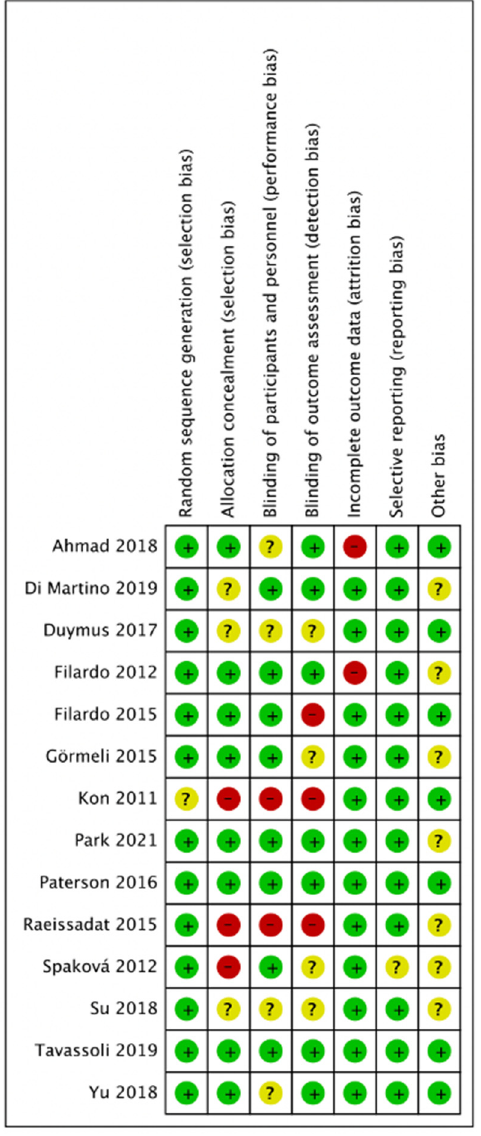
Figure 3. Summary of risk bias.